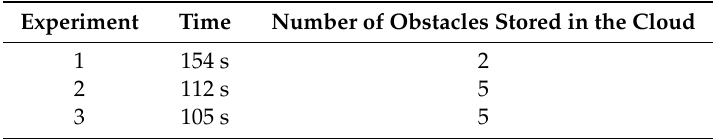
Table 1. Elapsed time with number of obstacles in three experiments.